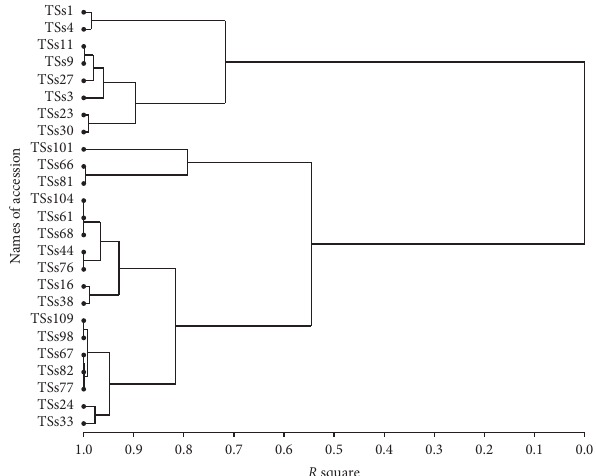
Figure 7: Clustering analysis of antinutrients in processed samples. TSs: Tropical Sphenostylis stenocarpa